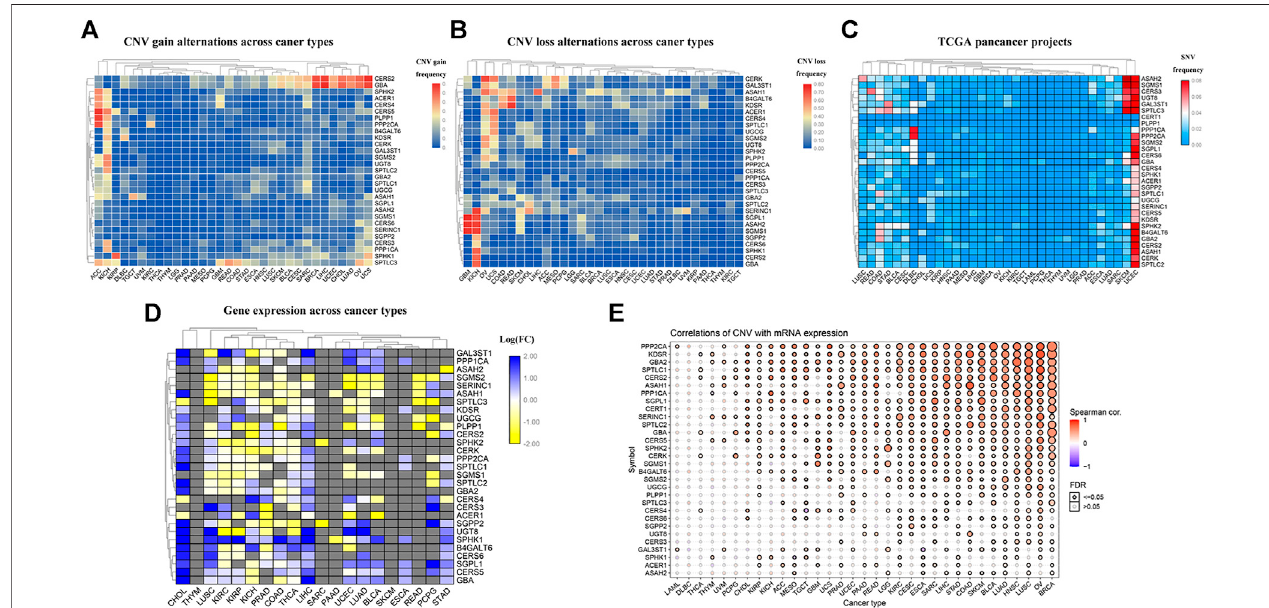
FIGURE2| Widespreadgeneticmutationsofsphingolipidpathwaygenes. (A) CNVgainsofsphingolipidpathwaygenesin32typesofcancers.Theadjacentcolor blockrepresentsthefrequencyofmutations,thered colorbar represents ahighmutationfrequency, andtheblue colorbarrepresentslowmutationfrequency. (B) CNV losses in sphingolipid pathway genes. The adjacent color block represents the frequency of mutations, the red color bar represents a high mutation frequency, and the blue color bar represents a low mutation frequency. (C) SNV in sphingolipid pathway genes. The adjacent color block represents the frequency of mutations, the red color bar represents a high mutation frequency, and the blue color bar represents a low mutation frequency. (D) mRNA expression of sphingolipid pathway genes. The blue color bar represents increased mRNA expression and the yellow color bar represents decreased mRNA expression. (E) Correlations of CNV and mRNA expression.Asolidsphereindicatesthattheresultisstatisticallysigni fi cant( p < 0.05),thesizeofthesphereindicatesthedegreeofcorrelation,andthelargerthesphere, the higher the degree of